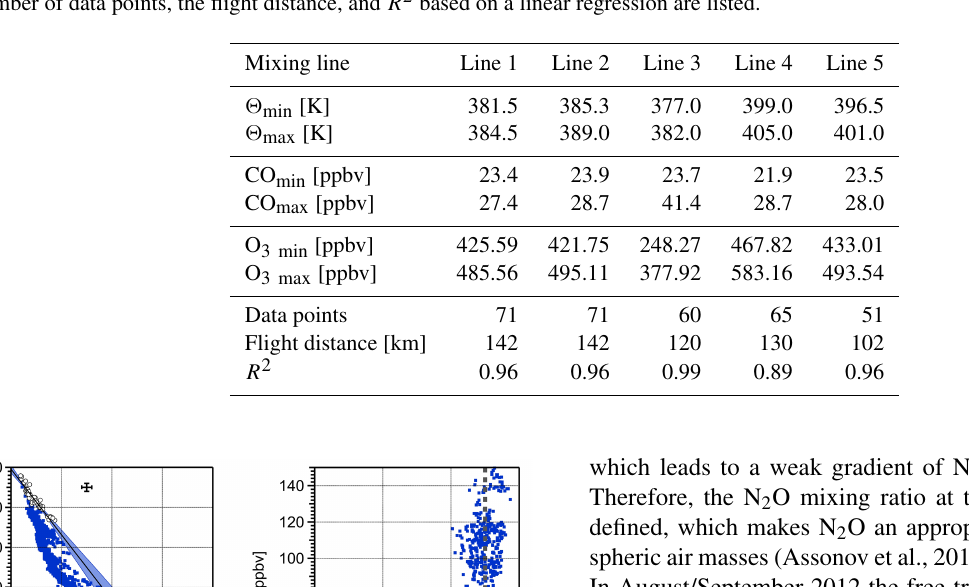
Table 1. Minimum and maximum values of potential temperature as well as CO and O 3 mixing ratios for every mixing line. Additionally, the number of data points, the flight distance, and R 2 based on a linear regression are listed.